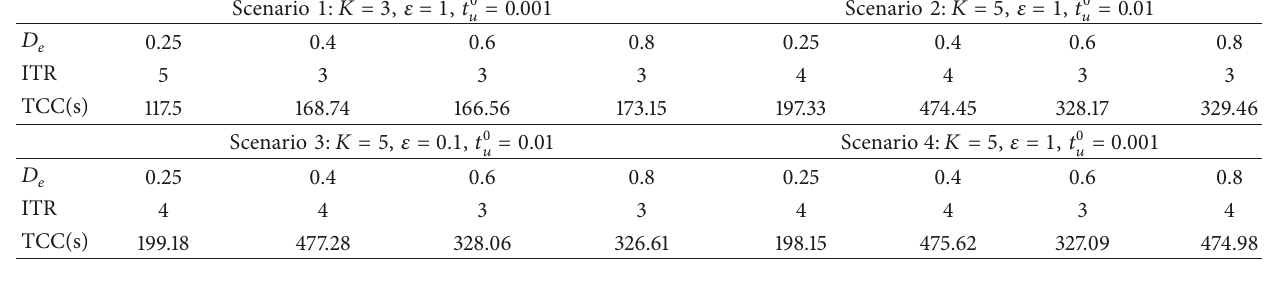
Table 4: Computational cost with different parameter settings for MNL.